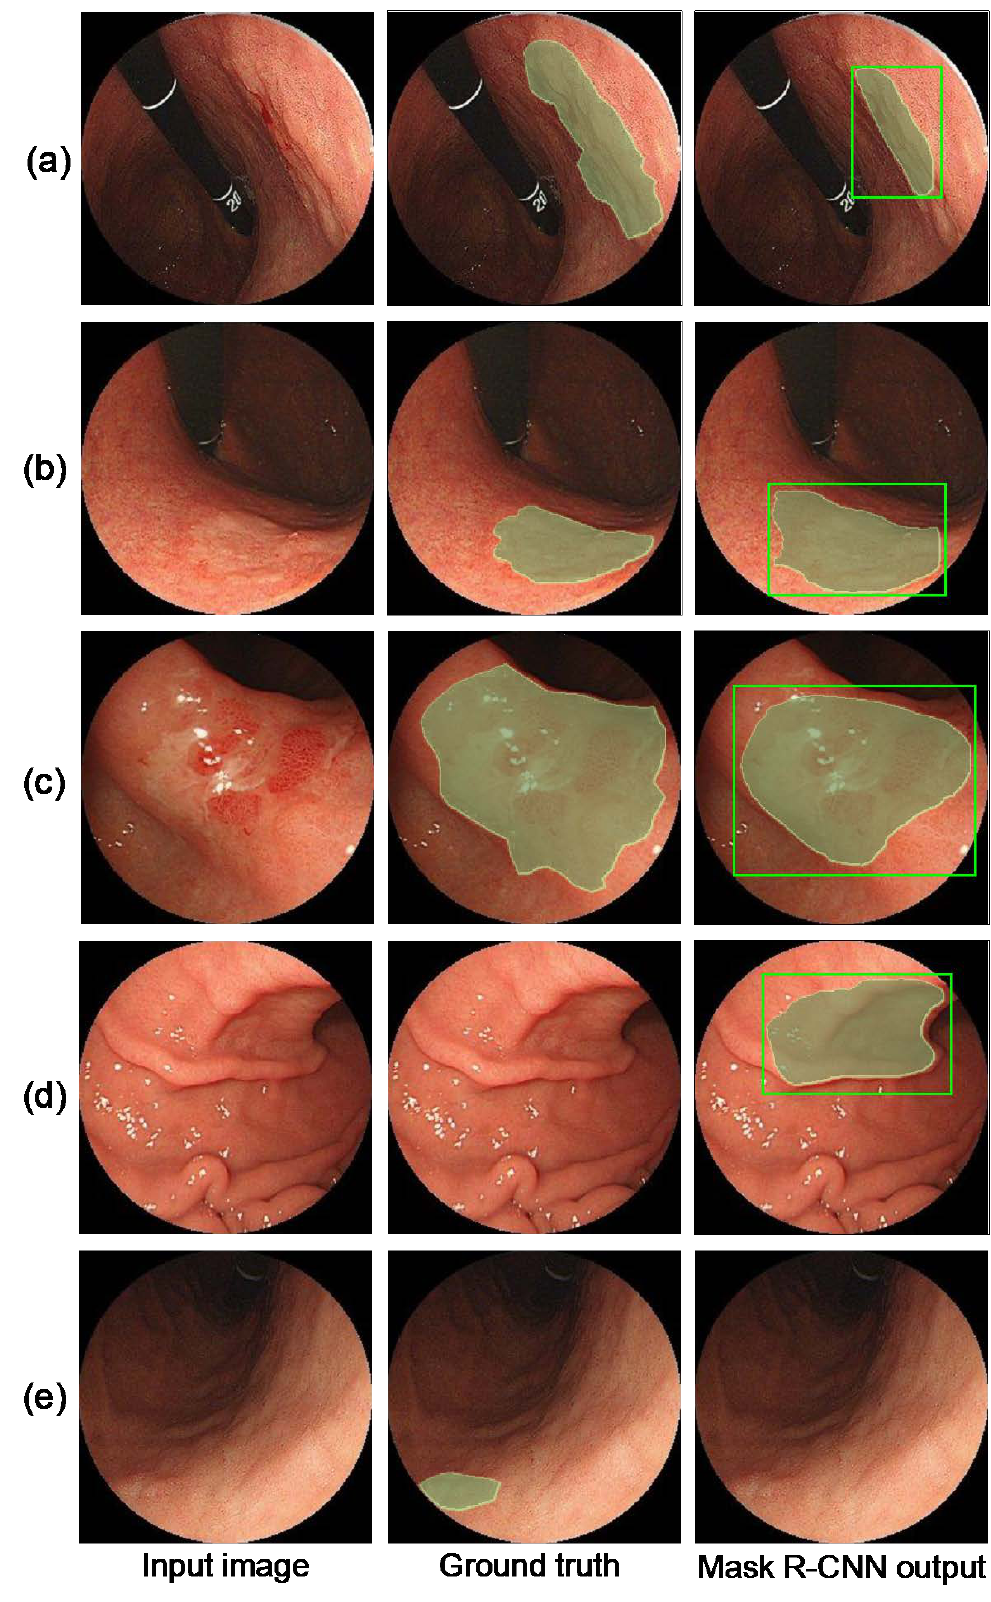
Figure 3. Detection results. ( a – c ) Successful gastric cancer detection, ( d ) false positives (FP) in healthy subjects, and ( e ) false negative in the abnormal